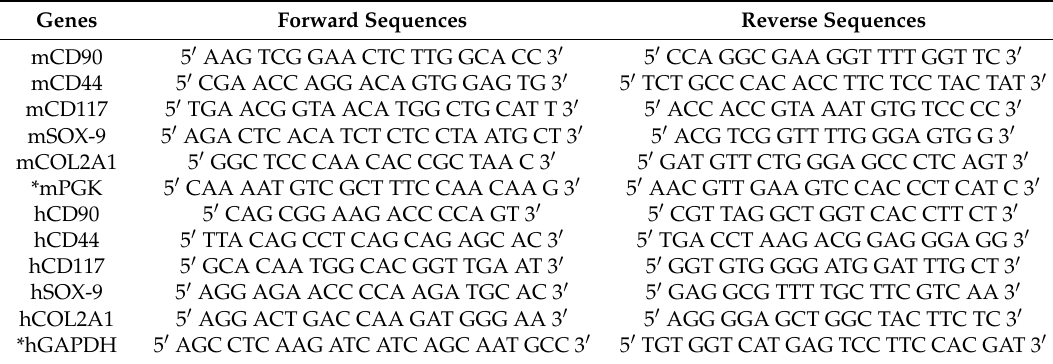
Table 1. Primers used for qRT-PCR on murine/human cartilage micro-grafts.